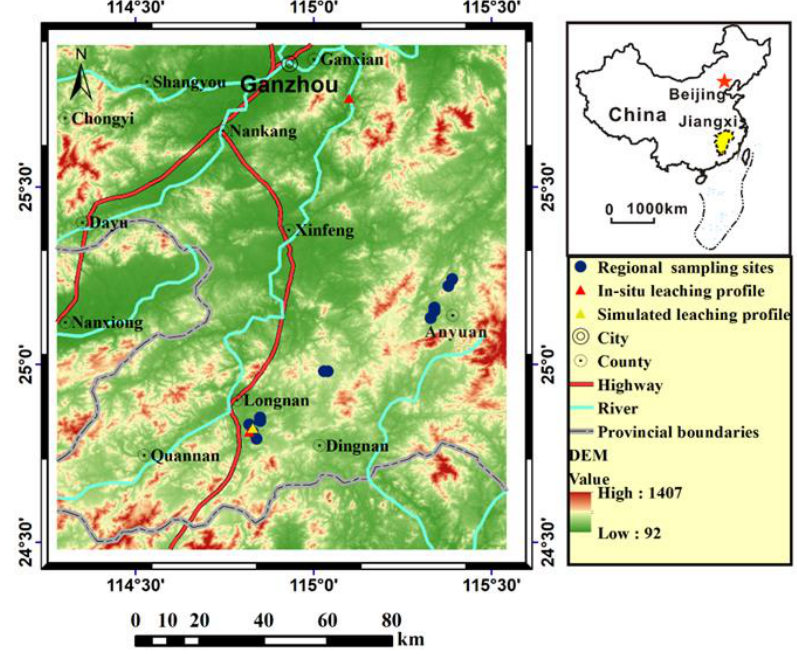
Figure 1. The location of sampling sites.